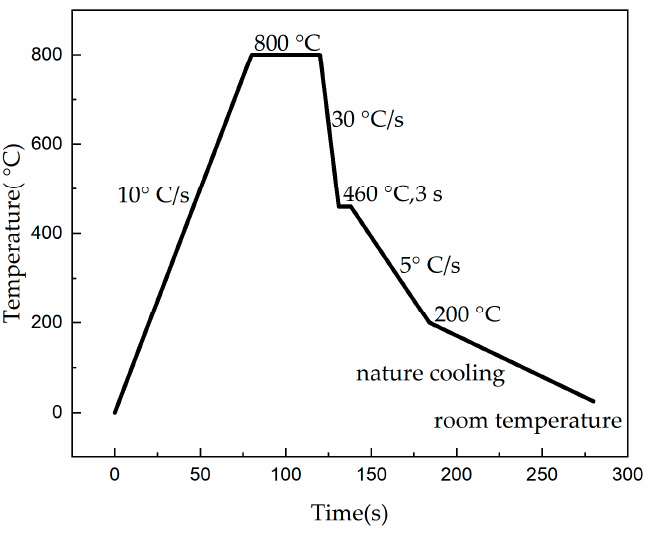
Figure 1. Experimental process control flow chart of hot-dip plating simulator. Table 1. The compositions of experimental coatings.